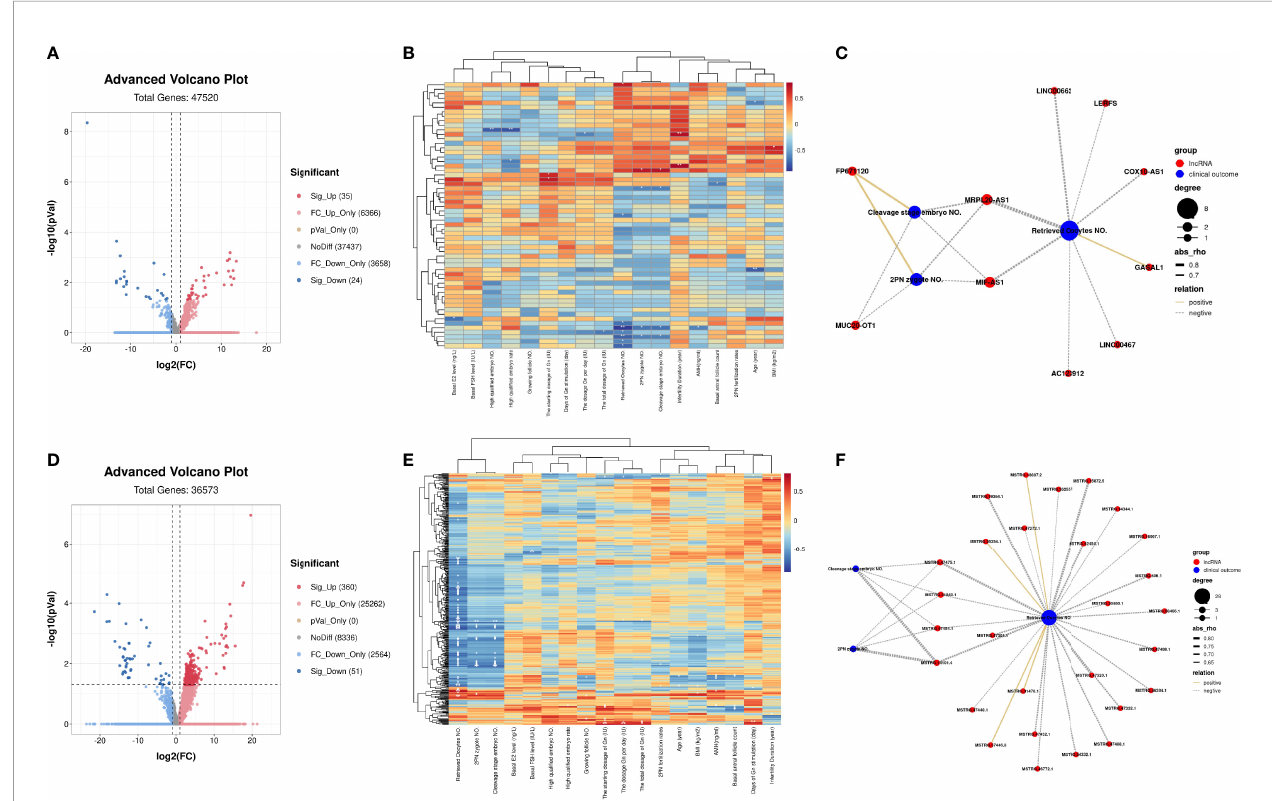
FIGURE 5 | LncRNA pro fi ling of GCs from patients with infertility associated with OEM. (A) Volcano map analysis of differentially expressed known lncRNA indicates signi fi cantly upregulated lncRNAs (red), downregulated signi fi cantly lncRNAs (blue), and non-signi fi cant lncRNAs (gray). (B) Correlation heatmap between differentially expressed known lncRNA and the clinical characteristics of RNA-seq samples. The ordinate represents known lncRNA, and the abscissa is clinical characteristics. (C) Co-expression network of clinical characteristics and known lncRNAs through Weighted Gene Co-expression Network Analysis (WGCNA); Cytoscape was used to visualize the network diagram (|correlation coef fi cient| > 0.5, p < 0.05). (D) Volcano map analysis of differentially expressed novel lncRNA. (E) Correlation heatmap between differentially expressed novel lncRNA and the clinical characteristics of RNA-seq samples. (F) Co-expression network of clinical characteristics and novel lncRNAs through WGCNA; Cytoscape was used to visualize the network diagram (|correlation coef fi cient| > 0.5, p < 0.05) (* p < 0.05, ** p < 0.01, *** p < 0.001) ( N MF = 6, N OEM =